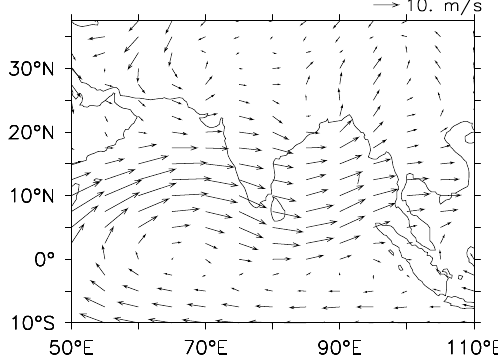
Fig. 11. June–September 850hPa wind (ms − 1 ) climatology for the period 1970–2000 from NCEP/NCAR reanalysis data (Kalnay et al., 1996).